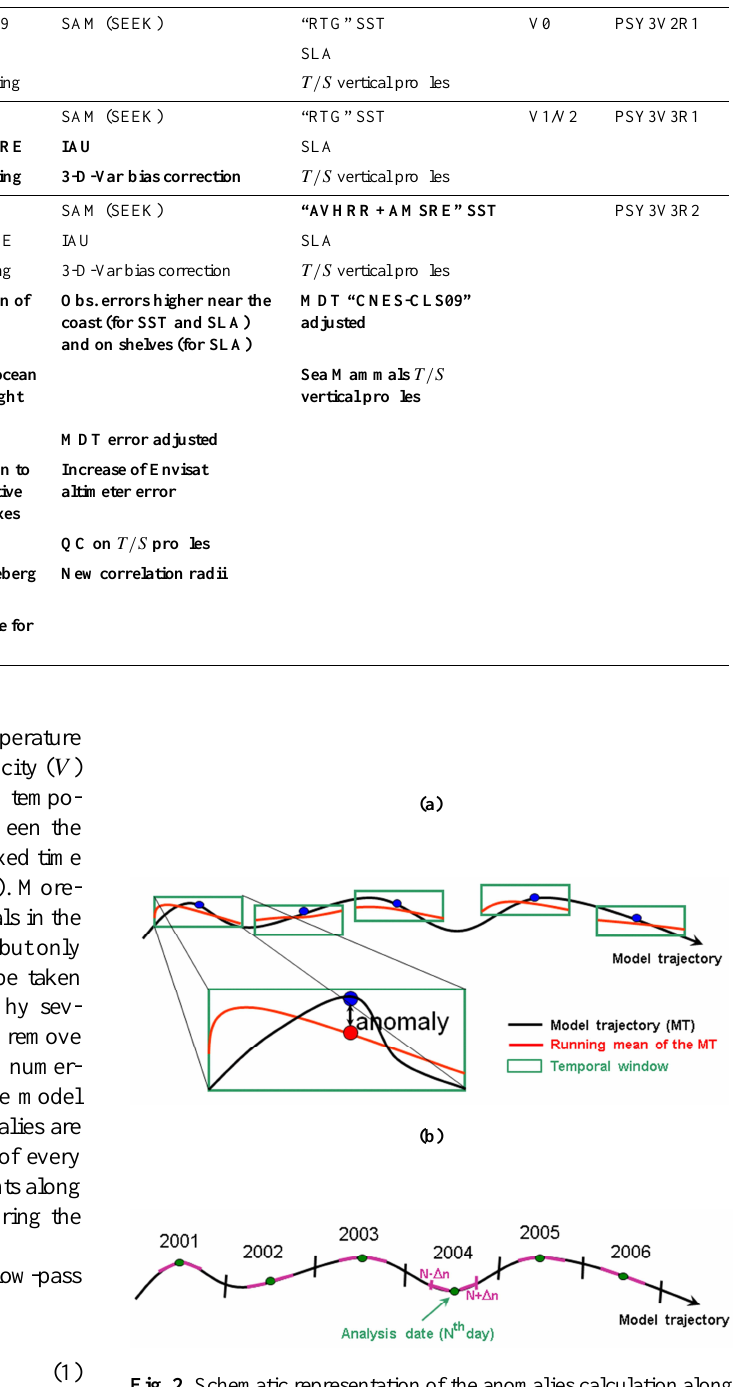
Fig. 2 . Schematic representation of the anomalies calculation along a model trajectory (a) and of the use of these anomalies to build the model forecast covariance (b) .